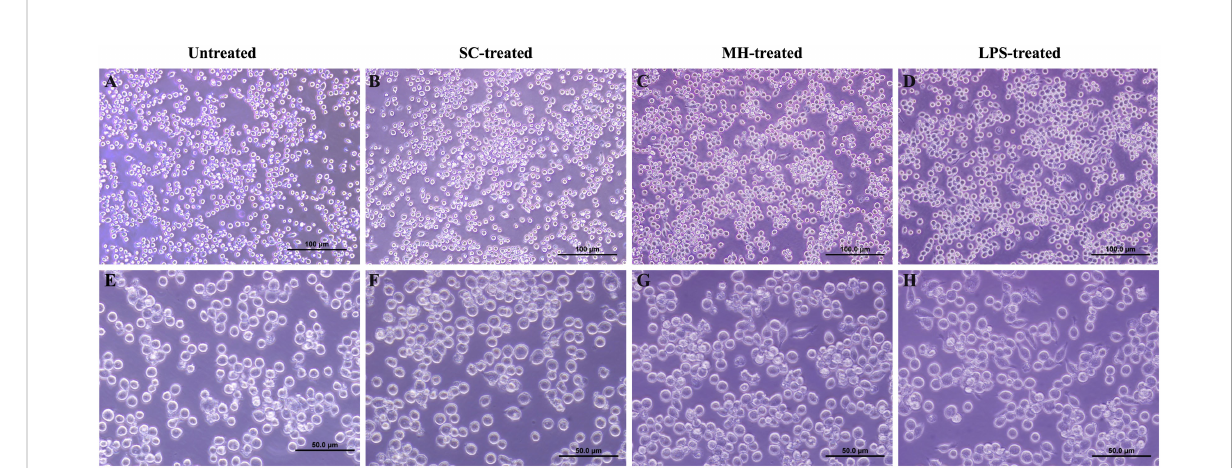
FIGURE 2 MH-treatment induces changes in the morphology of RAW264.7 cells. Morphology of RAW264.7 cells following 2 hours incubation in DMEM media (untreated cells) (A, E) and 2 hours treatment with SC (B, F) , MH (C, G) , and LPS (D, H) . Images were taken at 20X (Scale bar 100 m m) and 40X magni fi cation (Scale bar 50 m m).